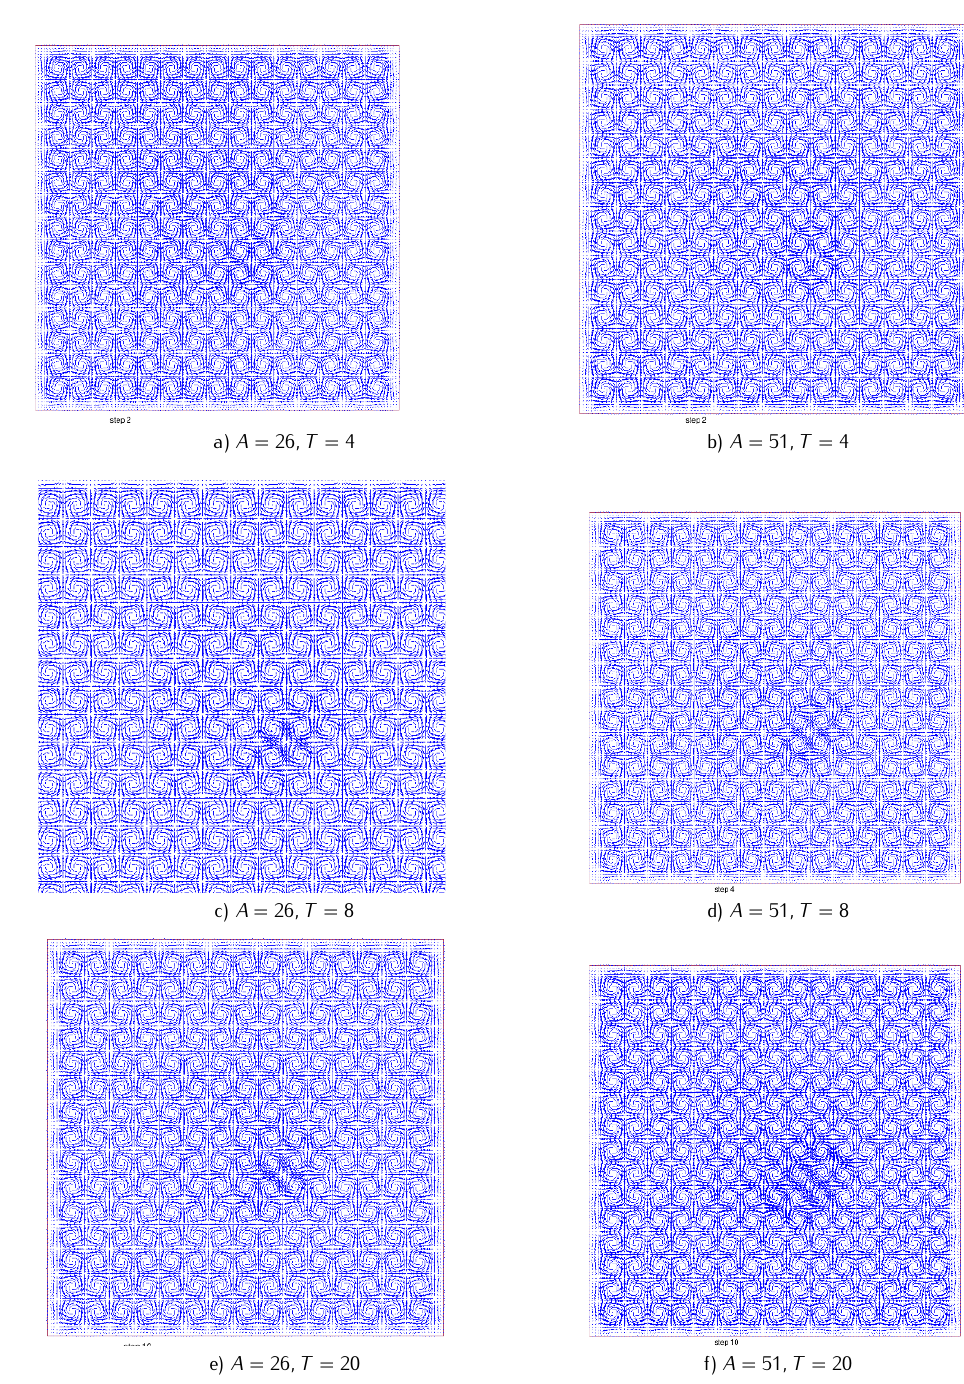
Figure 8. Test 1. Behavior of the computed vector electric field E h = ( E 1 h ,E 2 h ) in the domain decomposition FEM/FDM in Ω at different time moments. We show the electric vector field for different amplitude values A in (46) in Ω